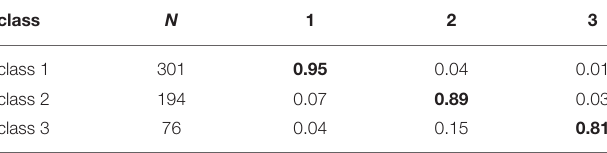
TABLE 2 | Average posterior probabilities for the 3-class